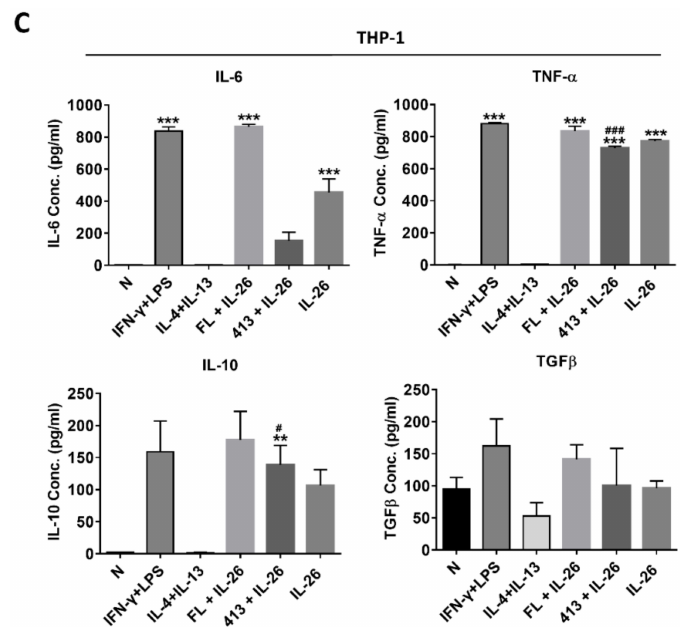
Figure 3. E ff ect of IL-26 on cytokine expression in M1 and M2 macrophage di ff erentiation. ( A ) RAW264.7 cells were treated with IFN- γ (20 ng / mL) or IL-4 (20 ng / mL) in the presence or absence of IL-26 for 24 h. ( B ) BMDM cells were pretreated with M-CSF (50 ng / mL) for 7 days and then treated with IFN- γ (20 ng / mL) or IL-4 (20 ng / mL) in the presence or absence of IL-26 for 24 h. ( C ) THP-1 cells treated with IFN- γ (20 ng / mL) plus LPS (10 ng / mL) or IL-4 (20 ng / mL) plus IL-13 (20 ng / mL) in the presence or absence of IL-26 for 24 h. After incubation, the cultured supernatants were analyzed by M1 macrophage cytokines IL-6 and TNF- α and M2 macrophage cytokines IL-10 and TGF β by ELISA. The data are the means ± S.D. of more than three cultures (* p < 0.05, ** p < 0.01, *** p < 0.001; # p < 0.05, ### p < 0.001 multiple comparison significance between IL-4 and IL-4 + IL-26, IFN γ and IFN γ + IL-26, or IL-4 + IL-13 and IL-4 + IL-13 + IL-26